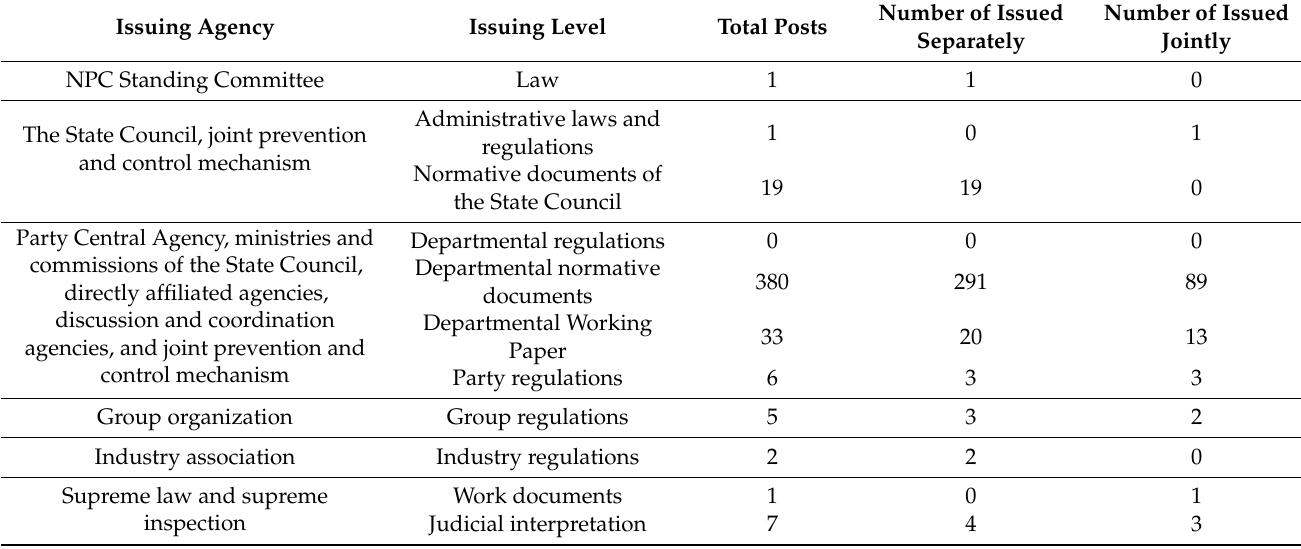
Table 2. Policy distribution during the outbreak of